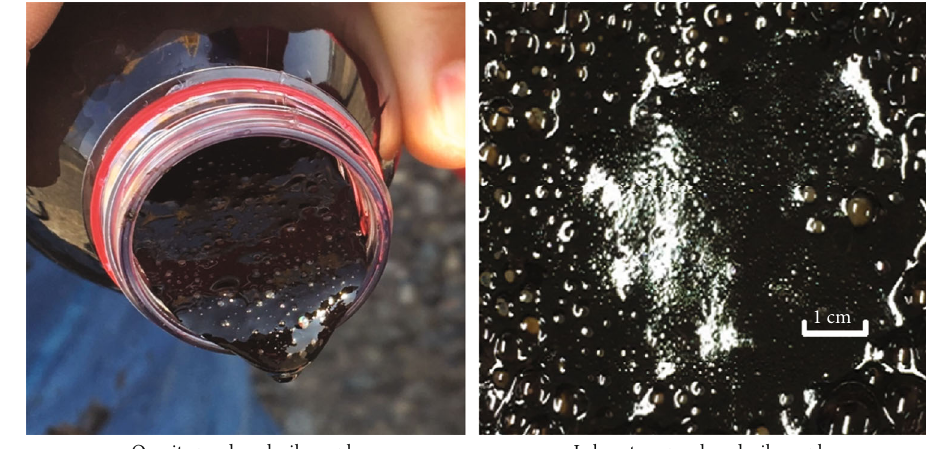
Figure 16: Emulsi fi ed foam oil produced via CO